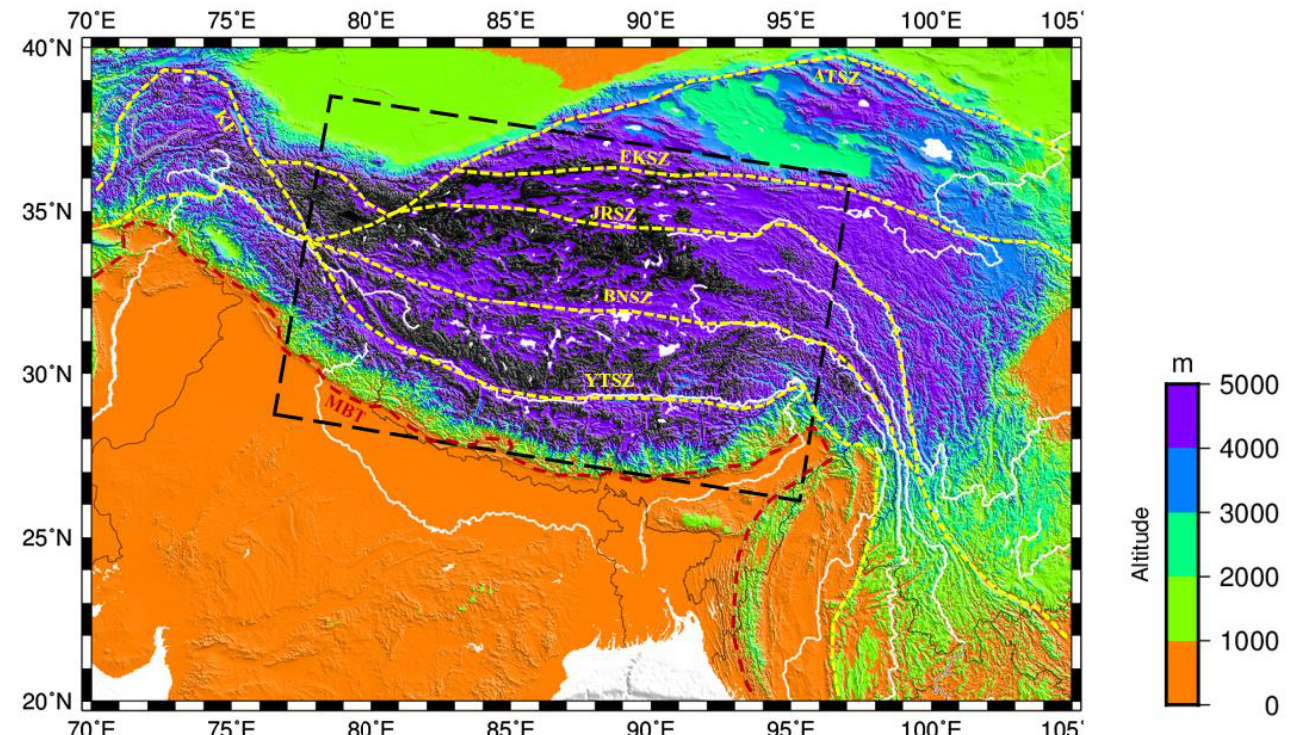
Figure 1. Tectonic map of the Himalayan orogen, including the major topographic features and sutures: YTSZ, Yarlung–Tsangpo suture zone; BNSZ, Bangong–Nujiang suture zone; JRSZ, Jinsha River suture zone; EKSZ, East Kunlun suture zone; ATSZ, Altyn Tagh suture zone; KF, Karakorum fault; MBT, main boundary thrust. Dashed lines indicate the main orogenic region focused by this study.